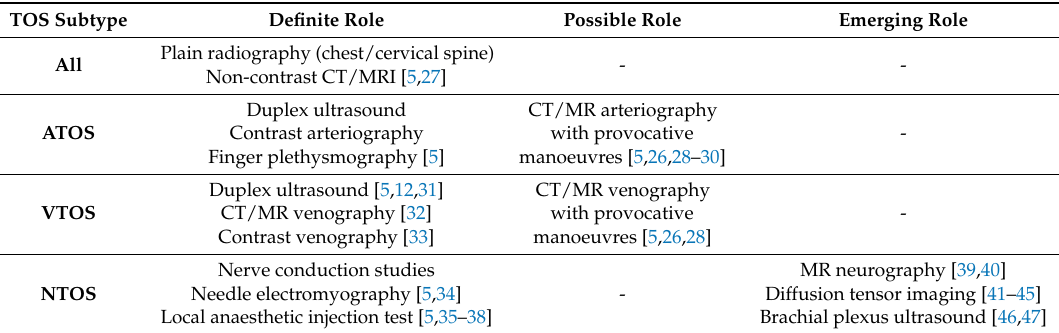
Table 2. Investigations in ATOS, VTOS, and